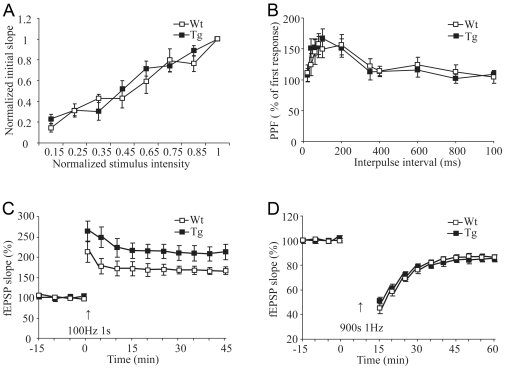
Synaptic Transmission and Plasticity in the Transgenic Rat Hippocampus.A: Normal CA3-CA1 input/output curve in Tg hippocampal slices. B: Normal paired-pulse facilitation at CA3-CA1 in Tg hippocampal slice. C: Tetanic stimulation induced larger LTP in transgenic slices than that of control. D: Low-frequency stimulation evoked the similar LTD between Tg and WT slices. Data were presented as the mean±SEM. Student's t-test was used for statistical analysis.